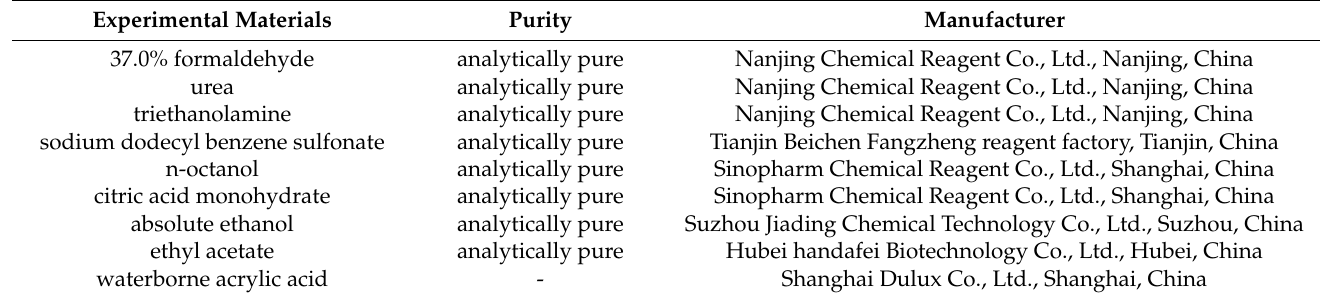
Table 1. Materials and